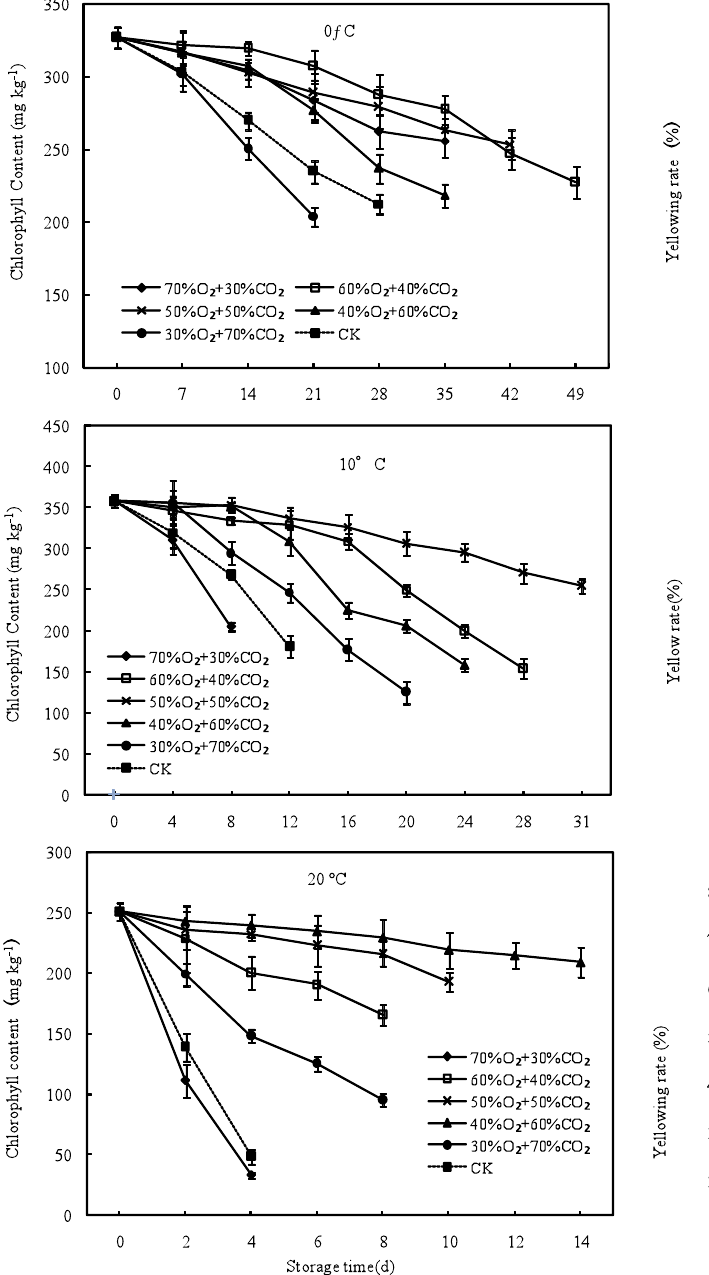
Fig. 5: Chlorophyll content of broccoli heads treated with varying O 2 /CO 2 levels at different temperature. Vertical bars indicate the standard de- at different temperature. Vertical bars indicate the standard de-at different temperature. Vertical bars indicate the standard de- different temperature. Vertical bars indicate the standard de- viations for each treatment (n=5). Air treatment was used as control.